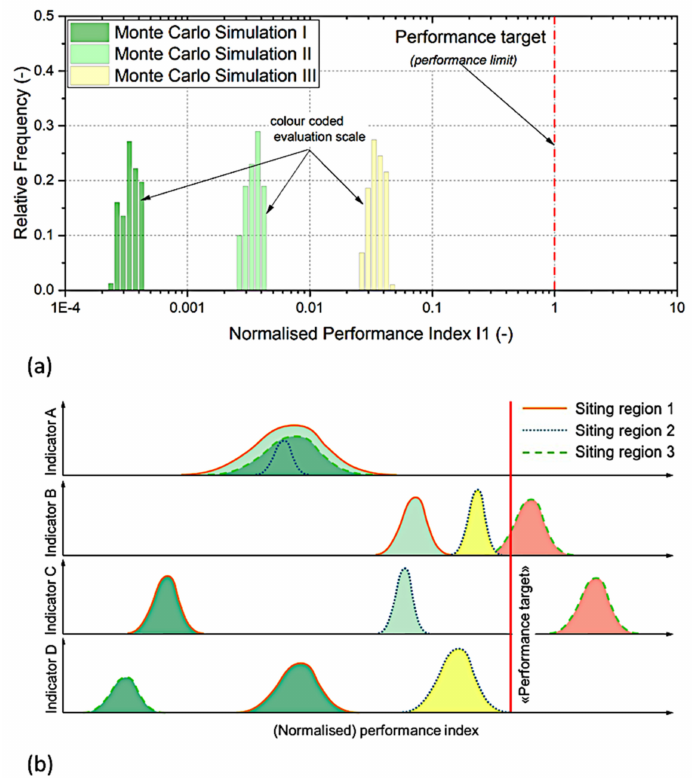
Figure 20. Schematic illustration of the use of four different indicators to compare siting regions: ( a ) comparison of different scenarios at one siting region; ( b ) comparison of different indicators evaluated at each of the siting regions.